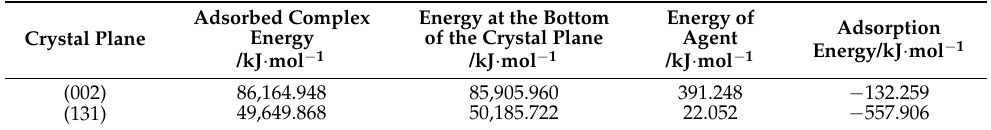
Table 5. Adsorption energy of muscovite (002) and (131) crystal